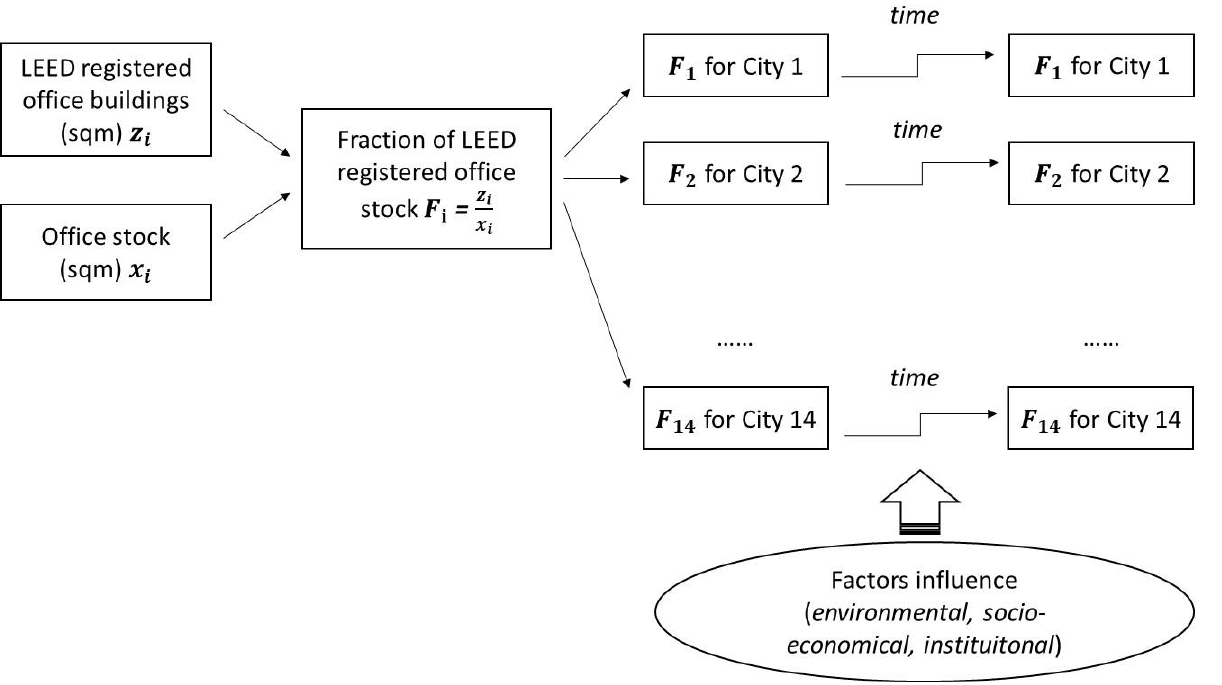
Figure 4. Analytical approach.